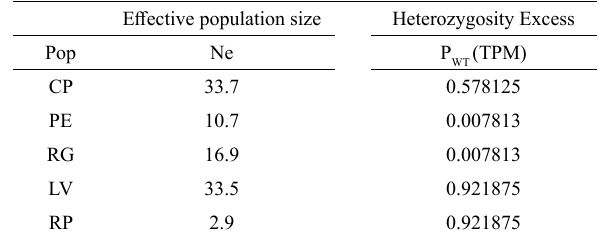
Table 4 – Effective population sizes (Ne) provided by the MIGRATE program and probabilities of the Wilcoxon test (P ), according to the two-phased WT mutation model (TPM), to test the heterozygosity excess, provided by the BOTTLENECK program, for five populations of Psalidodon scabripinnis from the Serra da Mantiqueira